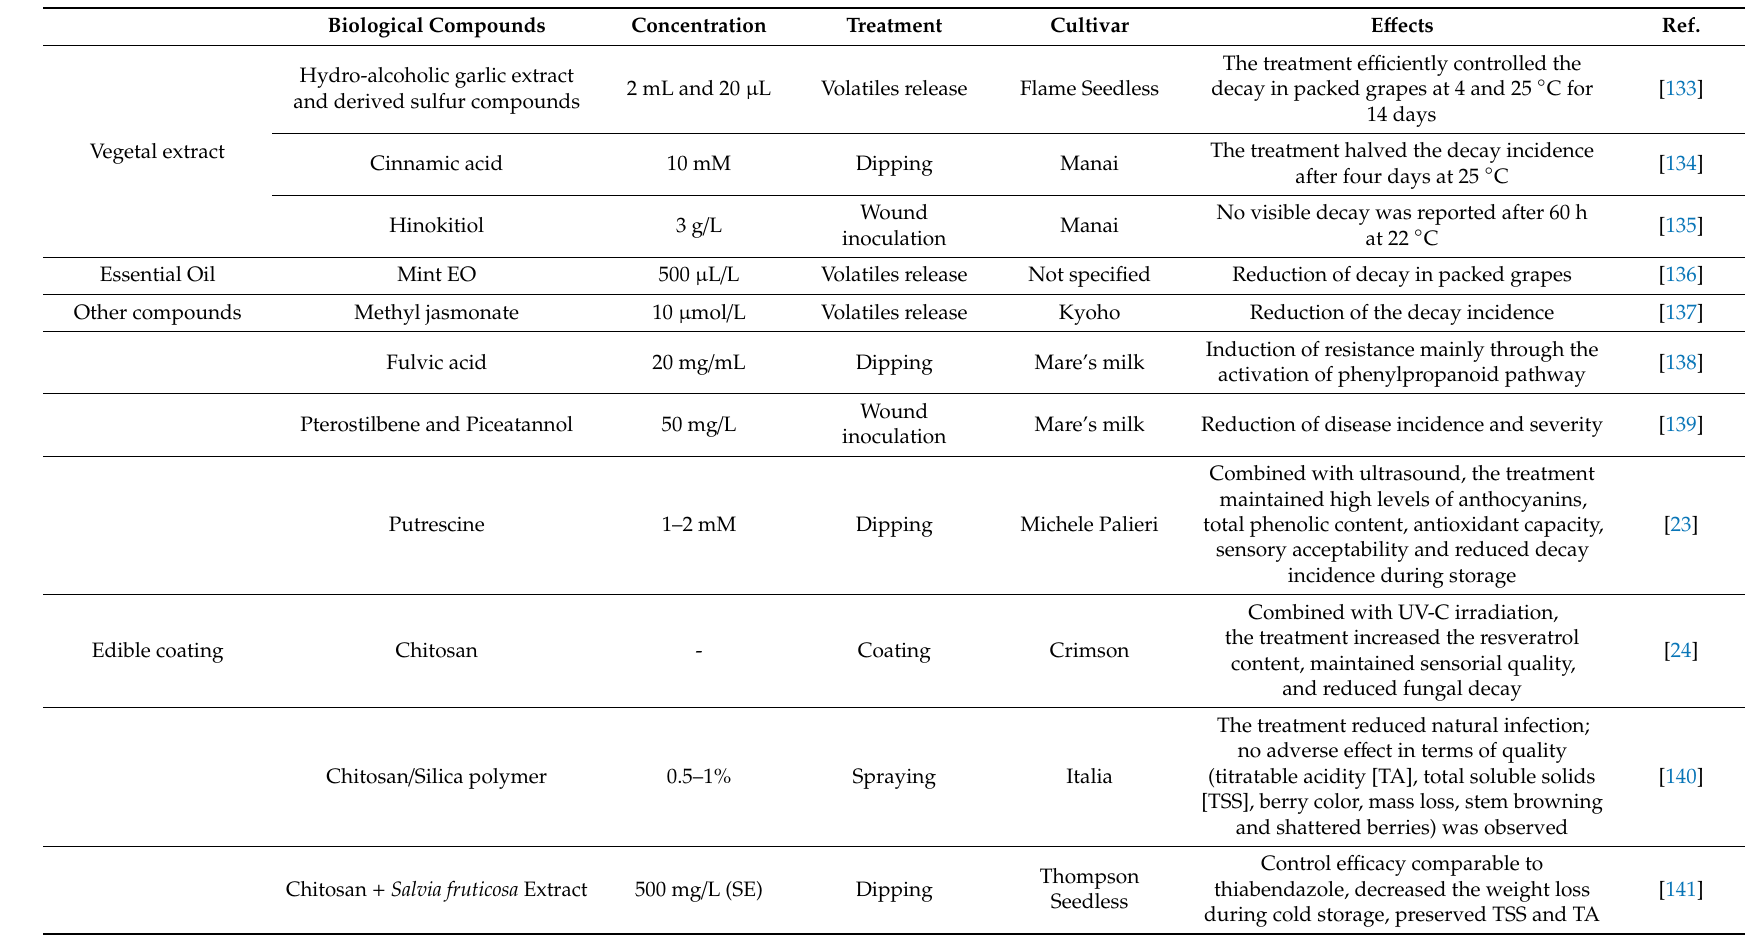
Table 4. Main biological compounds investigated in the last ten years against grey mould decay on table